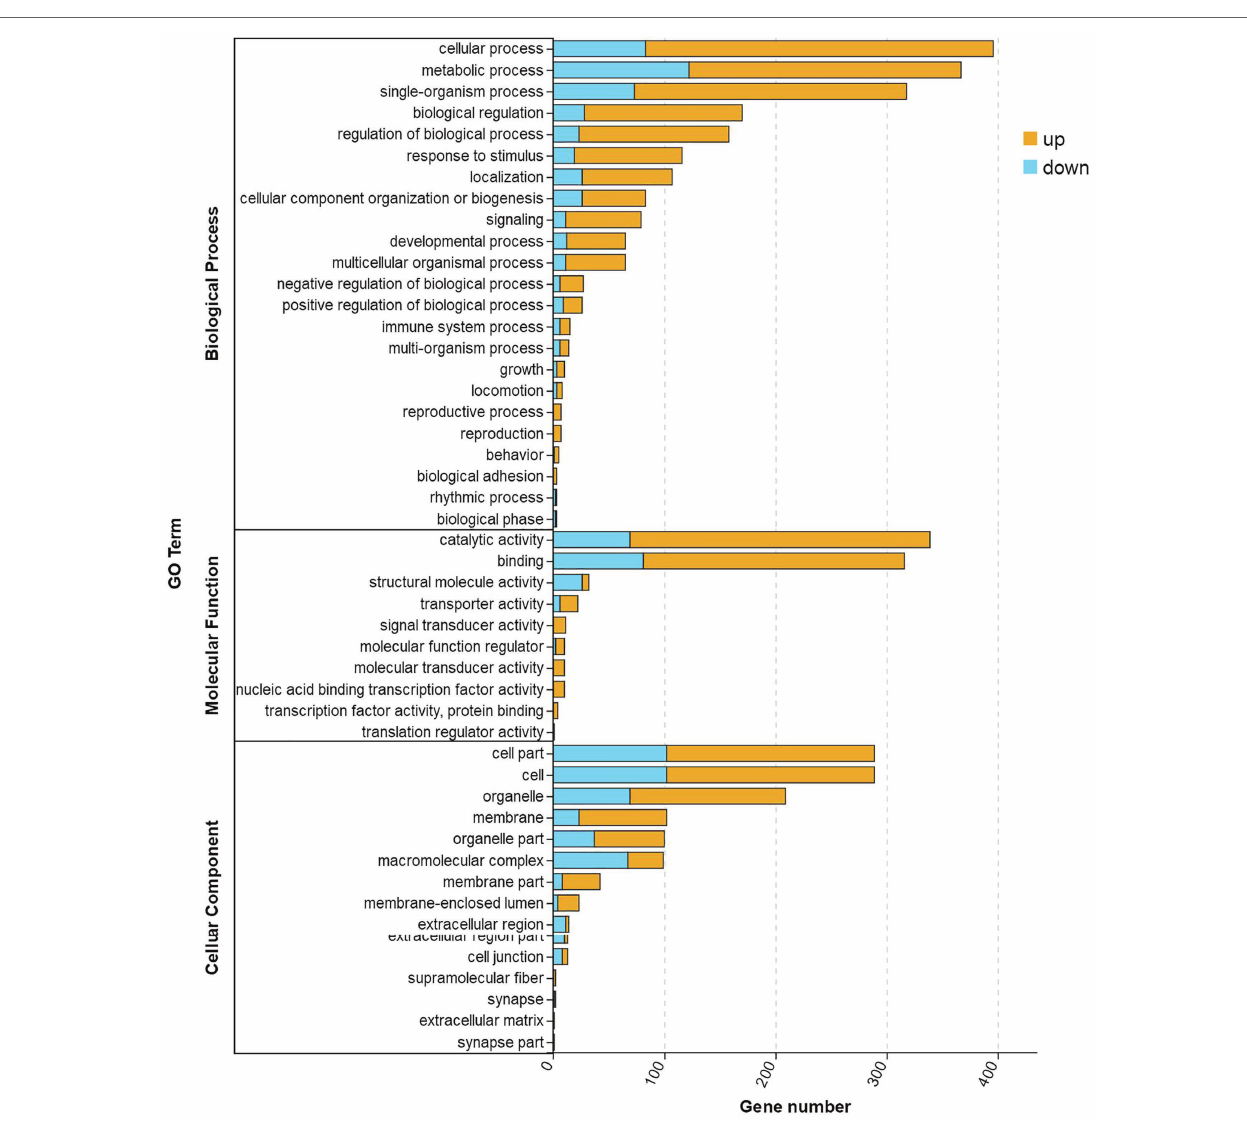
FIGURE 5 | GO enrichment analysis of DEGs in TWS119 fed and control P. vannamei . Three main GO categories: cellular component, molecular function, and biological process. X -axis indicates the number of unigenes and Y -axis indicates GO categories and the